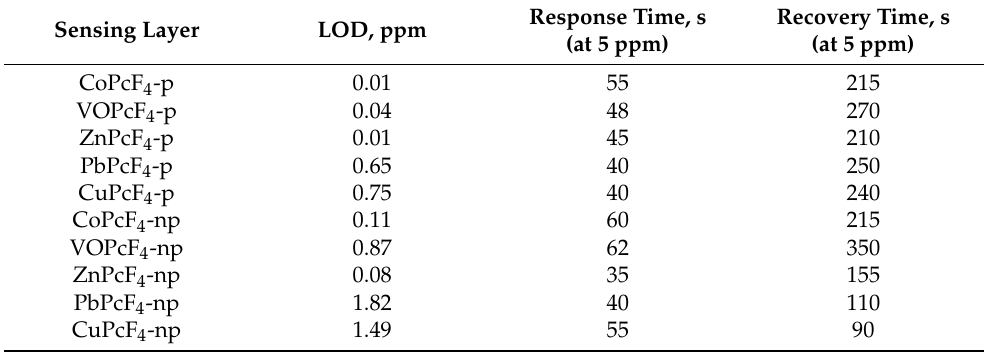
Table 1. Limits of ammonia detection (LOD), response and recovery times of MPcF 4 -p and MPcF 4 - np